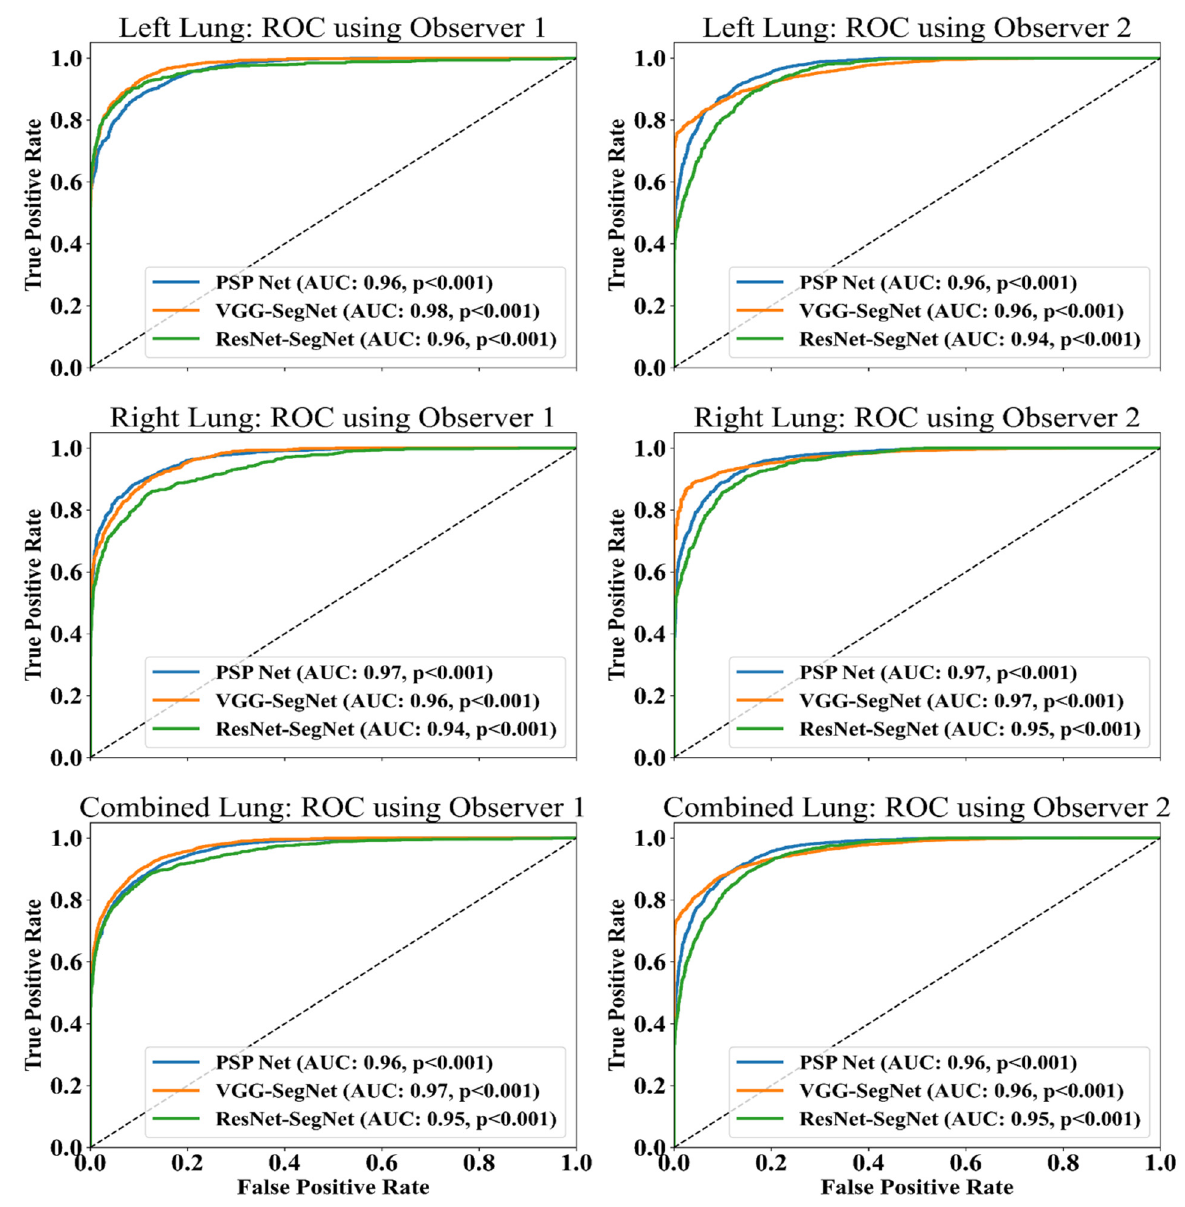
Figure 20. ROC and AUC curve for the three AI models: Observer 1 vs. Observer 2.